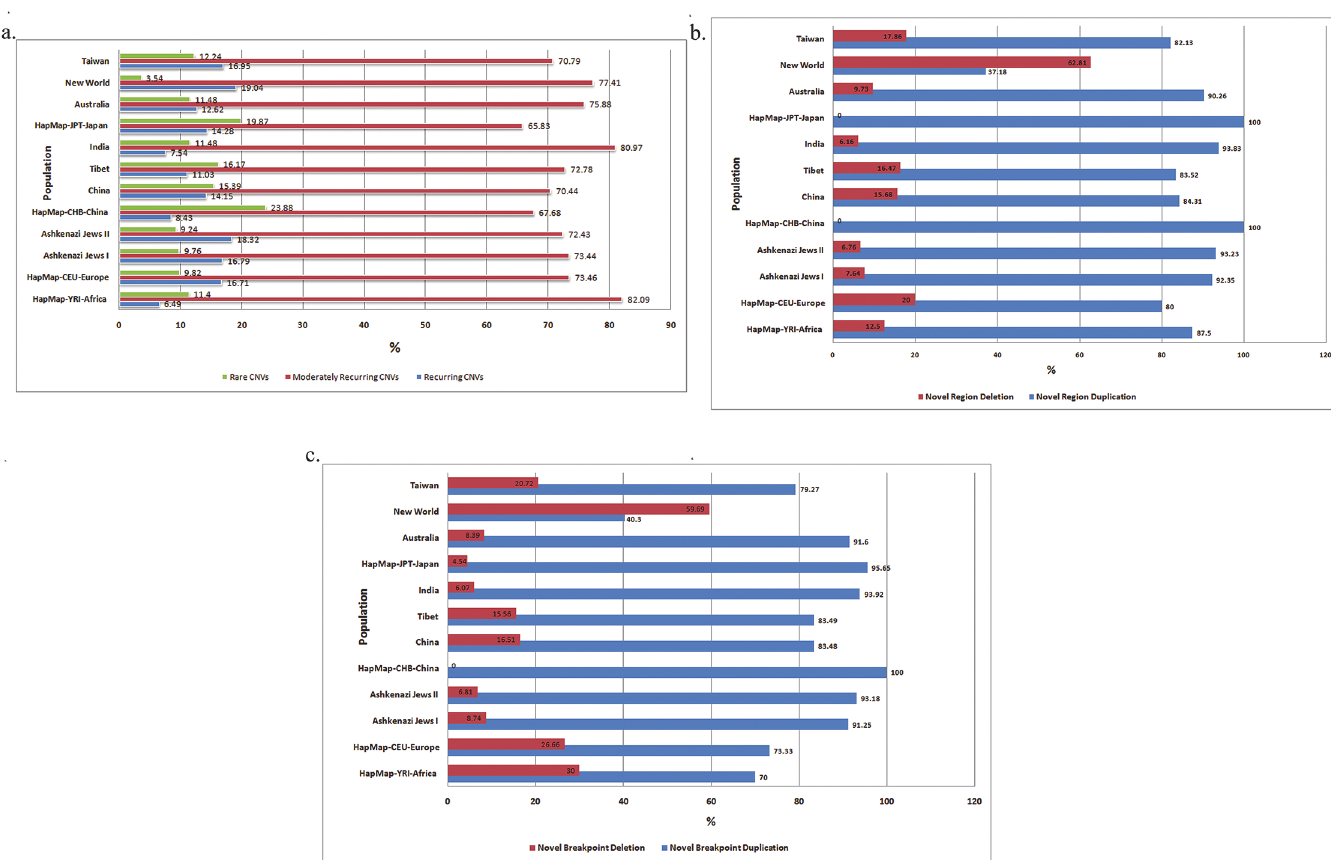
Fig 2. Nature of occurrence and location of CNVs. Each cluster represents an individual population. a) Frequencies of rare, moderately recurring and recurring CNVs are represented in the first second and third bars respectively. Recurring CNVs were found ranging from 6 – 18% in the entire study population and moderately recurring CNVs at 66 – 82%. Rare CNVs showed varied distribution across populations and were high in CHB, JPT, India, China, and Tibet, with a mean of 17% while New World showed the least (2%). b) Percent of novel regions found across populations are represented wherein red bars indicate deletions and blue bars indicate duplications. Duplication CNVs were higher with a mean of 85.3% than deletion CNVs (mean of 14.6%). c) Percent of novel breakpoints wherein red bars indicate deletions and blue bars indicate duplications. Novel breakpoint duplications ( > 70 – 100%) were greater than deletions